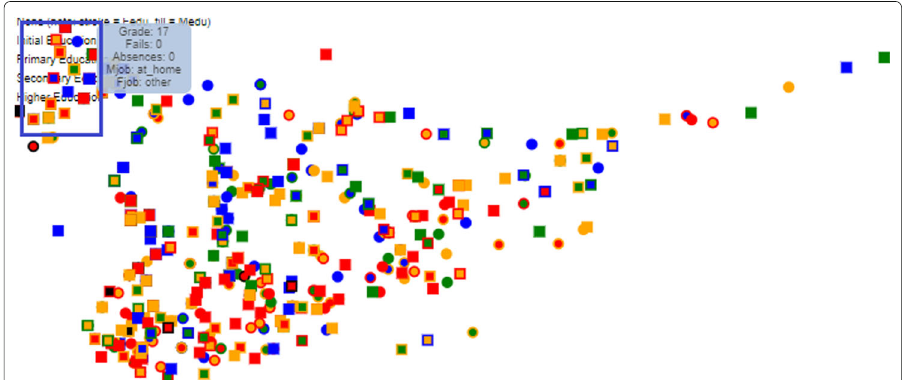
Fig. 23 Isomap for "Portuguese" class, period 2, considering both